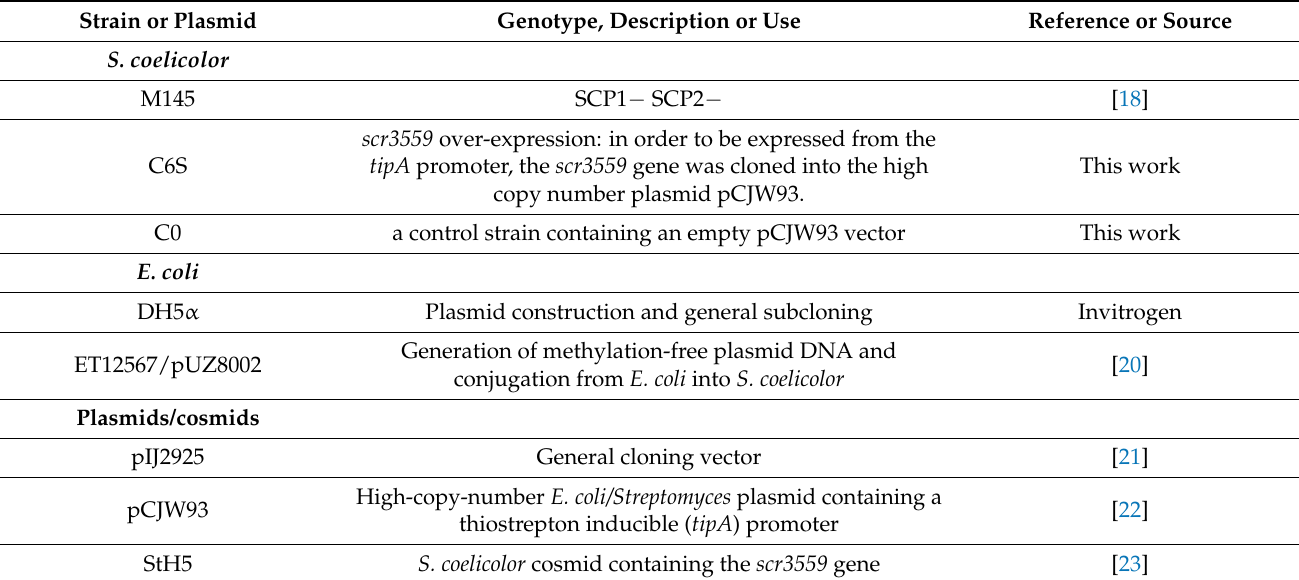
Table 1. Bacterial strains and plasmids used in this